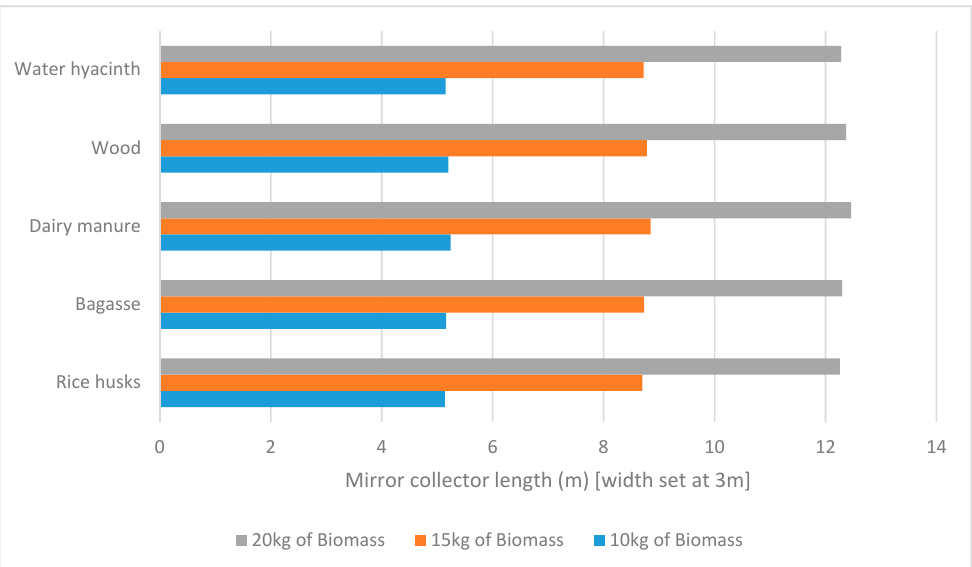
Figure 4. Effect of biomass and biomass mass on the length of mirror required. Figure 4. E ff ect of biomass and biomass mass on the length of mirror